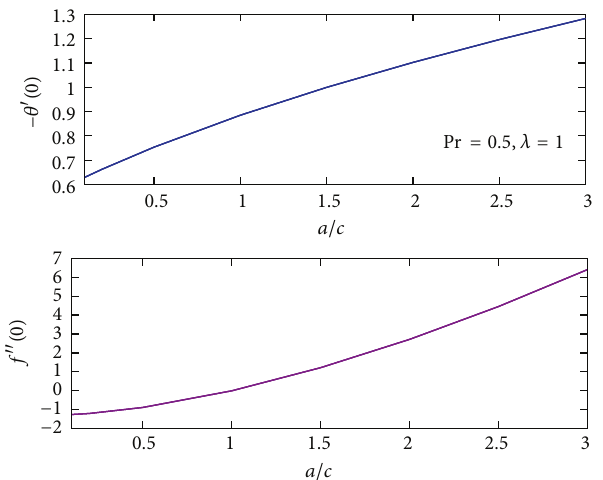
Figure 13: Values of 𝑓 󸀠󸀠 (0) and −𝜃 󸀠 (0) for various values of 𝑎/𝑐 .